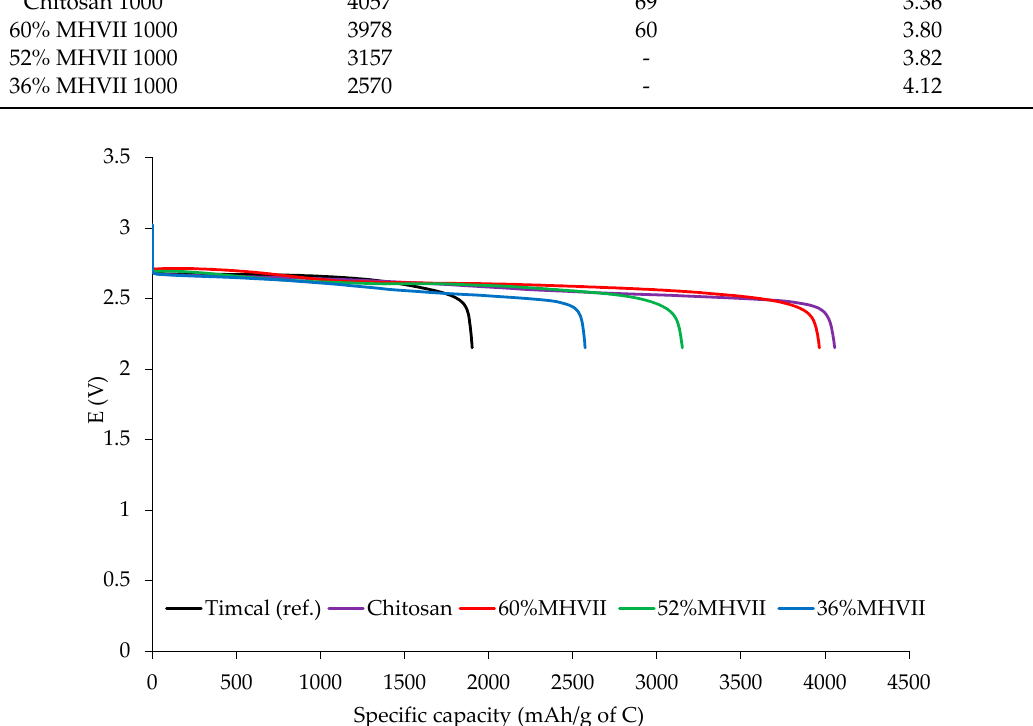
Figure 9. Discharge capacities for the different carbons.